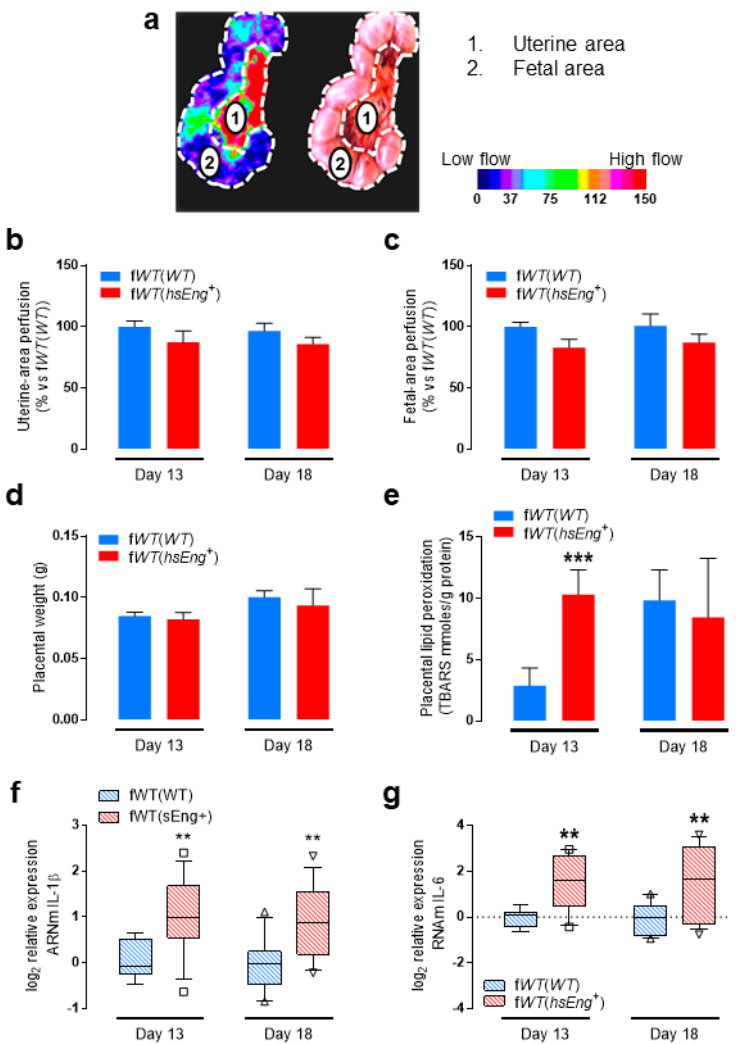
Figure 3. Pregnant f WT ( hsEng + ) mice present placental alterations. ( a ) Representative image of the analysis of placental and fetal perfusion by laser Doppler imaging. For each scan, the algorithm builds up a color-coded image representing tissue perfusion (left) and records a color photograph at the same time (right). Perfusion was determined in two different areas defined by color photograph, i.e., uterine area and fetal area. As shown in the scale, the pseudocolor ranges from left to right, therefore, blue represents the lowest perfusion and red the highest perfusion; ( b ) Quantification of the uterine- area perfusion from f WT ( WT ) and f WT ( hsEng + ) mice at Day 13 (f WT ( WT ) n = 7 and f WT ( hsEng + ) n = 7) and Day 18 ((f WT ( WT ) n = 11 and f WT ( hsEng + ) n = 15) of gestation; ( c ) Quantification of the fetal-area perfusion from f WT ( WT ) and f WT ( hsEng + ) mice at Day 13 (f WT ( WT ) n = 7 and f WT ( hsEng + ) n = 7) and Day 18 (f WT ( WT ) n = 11 and f WT ( hsEng + ) n = 15) of gestation; ( d ) Weight of the placentas from f WT ( WT ) and f WT ( hsEng + ) mice at Day 13 (f WT ( WT ) n = 7 and f WT ( hsEng + ) n = 7) and Day 18 (f WT ( WT ) n = 9 and f WT ( hsEng + ) n = 8] of gestation; ( e ) Lipid peroxidation, measured as presence of thiobarbituric acid-reactive substances (TBARS), of placentas from f WT ( WT ) and f WT ( hsEng + ) mice at Day 13 (f WT ( WT ) n = 20 and f WT ( hsEng + ) n = 21) and Day 18 (f WT ( WT ) n = 13 and f WT ( hsEng + ) n = 12) of gestation; ( f ) qRT-PCR analysis of IL-1 β expression in the placentas from f WT ( WT ) and f WT ( hsEng + ) mice at Day 13 (f WT ( WT ) n = 12 and f WT ( hsEng + ) n = 13) and Day 18 (f WT ( WT ) n = 12 and f WT ( hsEng + ) n = 15) of gestation; ( g ) qRT-PCR analysis of IL-6 expression in the placentas from f WT ( WT ) and f WT ( hsEng + ) mice at Day 13 (f WT ( WT ) n = 12 and f WT ( hsEng + ) n = 13) and Day 18 (f WT ( WT ) n = 12 and f WT ( hsEng + ) n = 15) of gestation. Mean ± SEM are displayed. ** p < 0.01 and *** p < 0.001 of f WT ( hsEng + ) vs. f WT ( WT